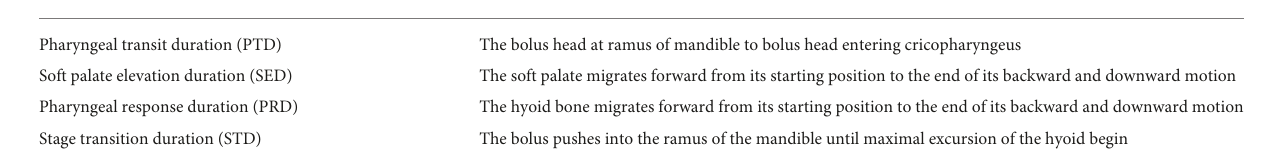
TABLE 1 The definition of different measures of duration.